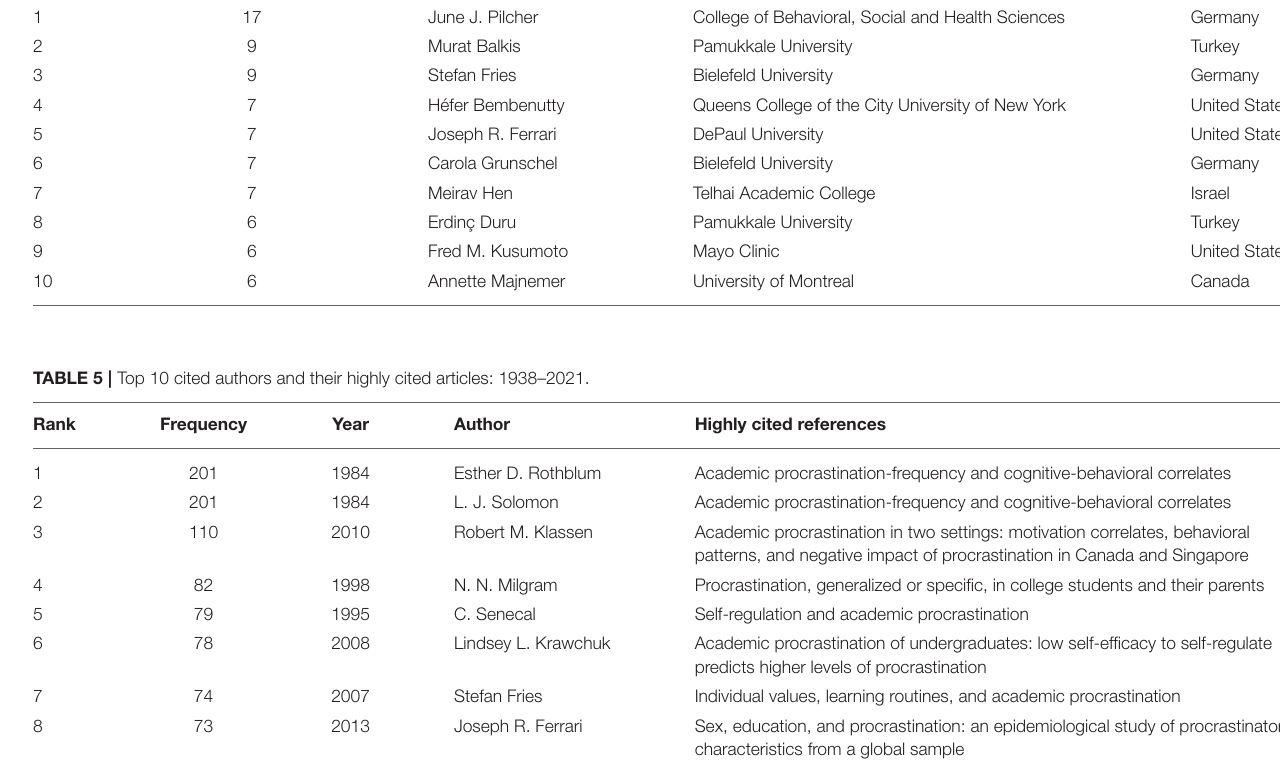
TABLE 4 | Top 10 most productive authors in academic procrastination research: 1938–2021. Rank